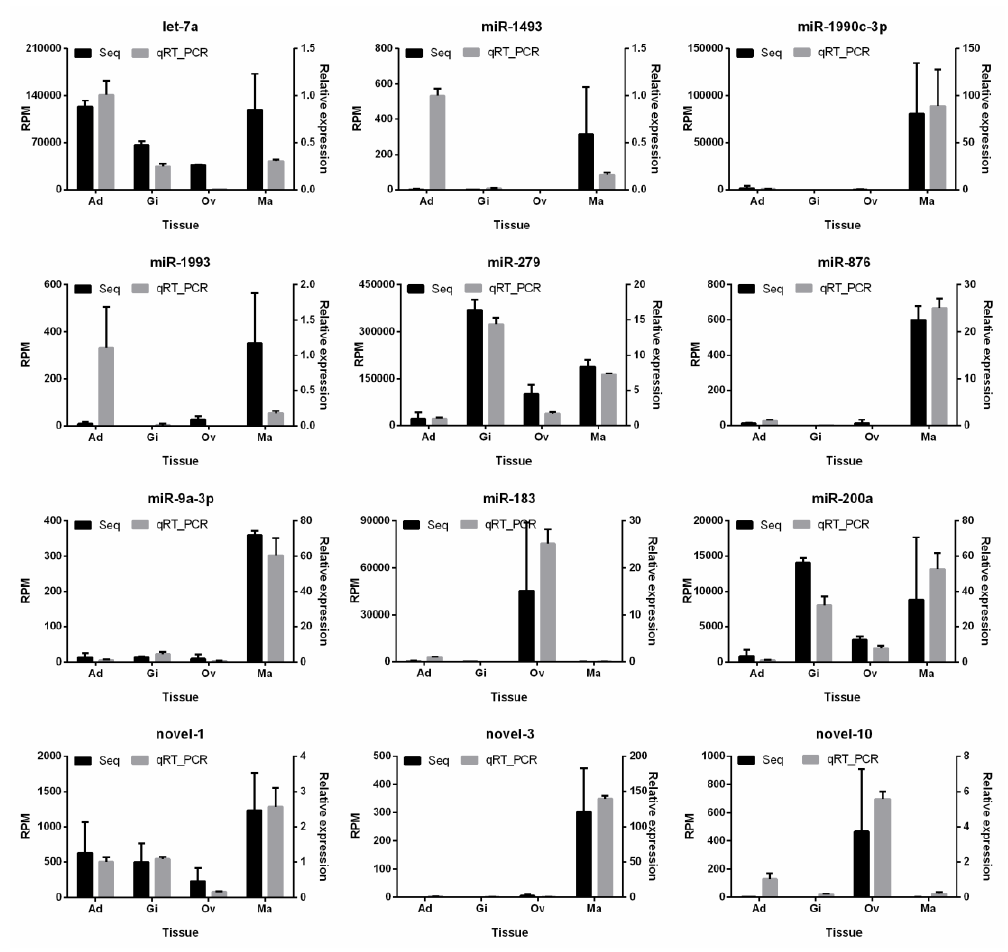
Figure 4. qRT-PCR validation of miRNAs expressed in P. fucata somatic and ovary tissues. Ad: adductor muscle; Gi: gill; Ov: ovary; Ma: mantle; RPM: reads per million reads; Seq: high-throughput sequencing.